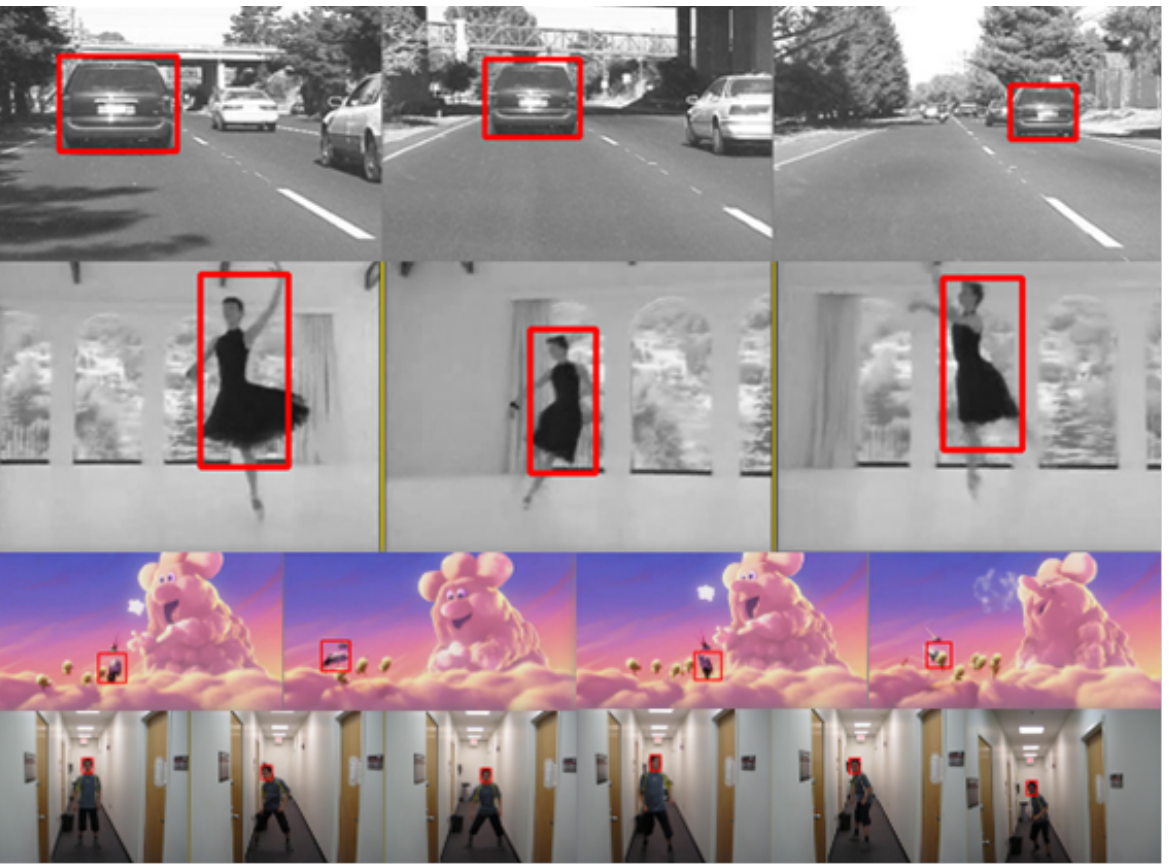
Figure 6. Several challenging video sequences in OTB-2015 involving target change. Pictures from top to bottom: Car4, Dancer, Bird2, Boy. Attributes: SV, DEF, IPR, OPR. In these four scenarios, even though the appearance of the target changes dramatically, the tracking recognition effect is good and there is no significant drift or tracking